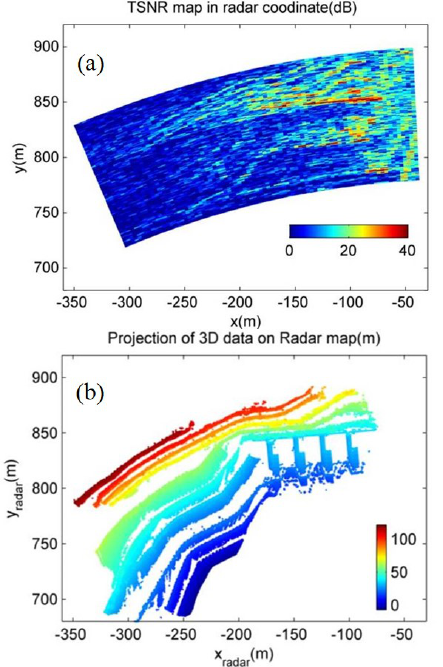
Figure 10. Matching of terrain point and pixel based Minimum distance measurement: (a) TSNR image in high slope area; (b) projection of 3D terrain coordinate of high slope to radar plane.